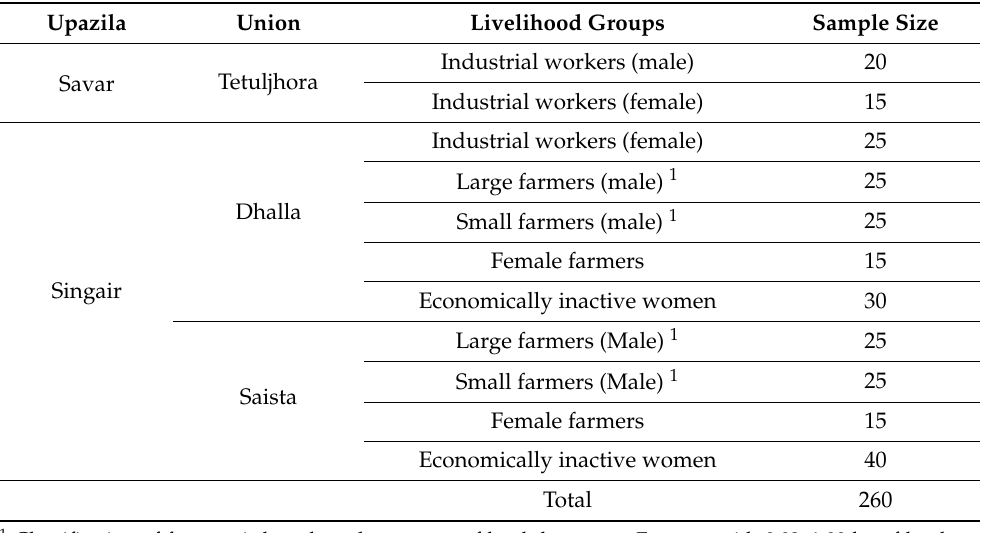
Table 1. Distribution of sample size in the study